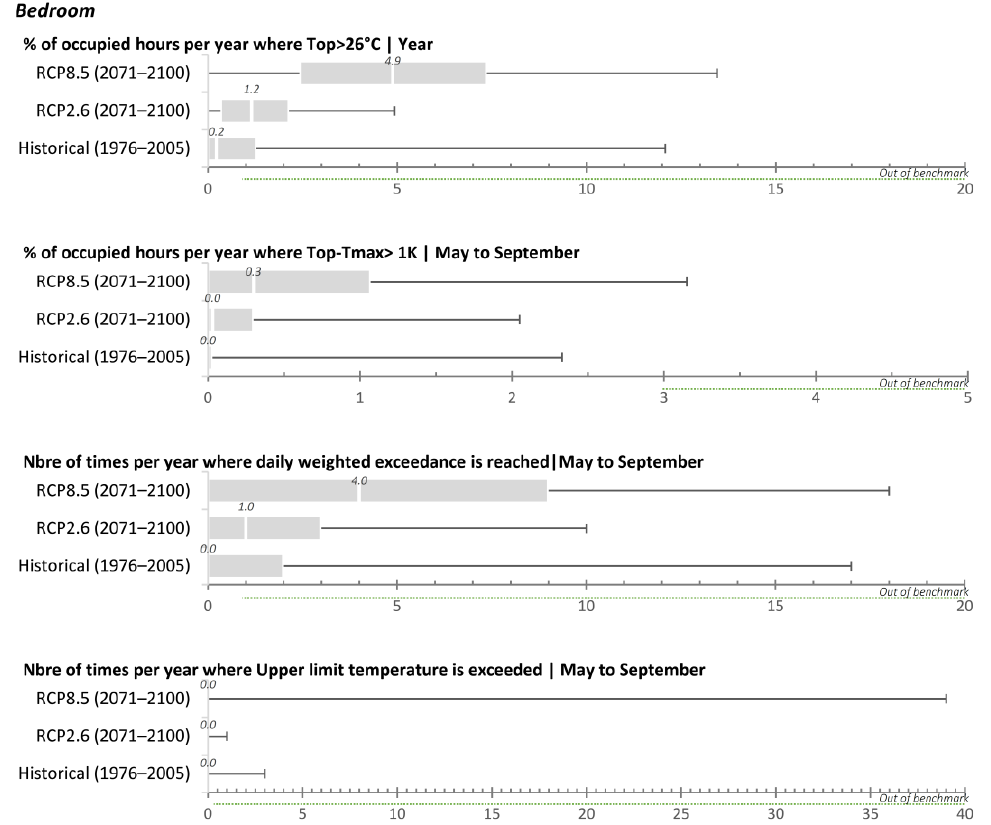
Figure 8. Summer thermal comfort evaluation under historical (1976 – 2005), RCP2.6 (2071 – 2100) and RCP8.5 (2071 – 2100) scenarios resulting from the application of the criteria presented in Table 3 for the bedroom.